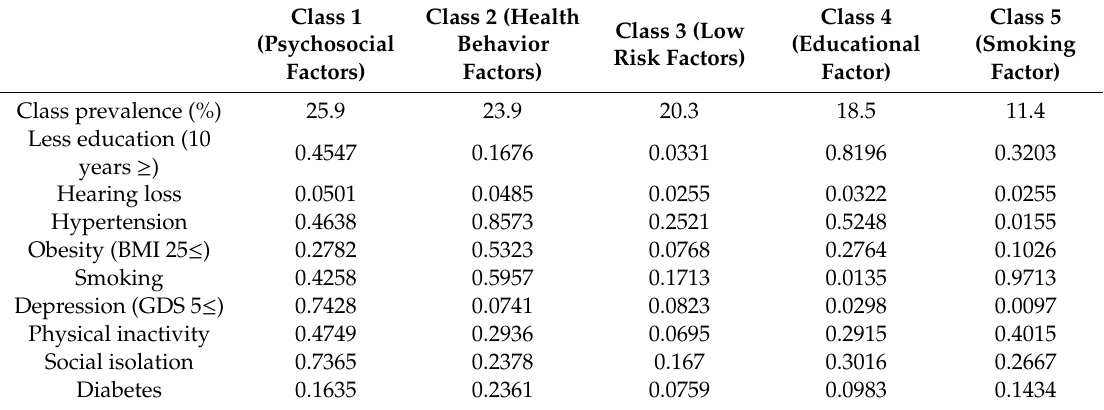
Table 3. Conditional probabilities of latent modifiable risk factor